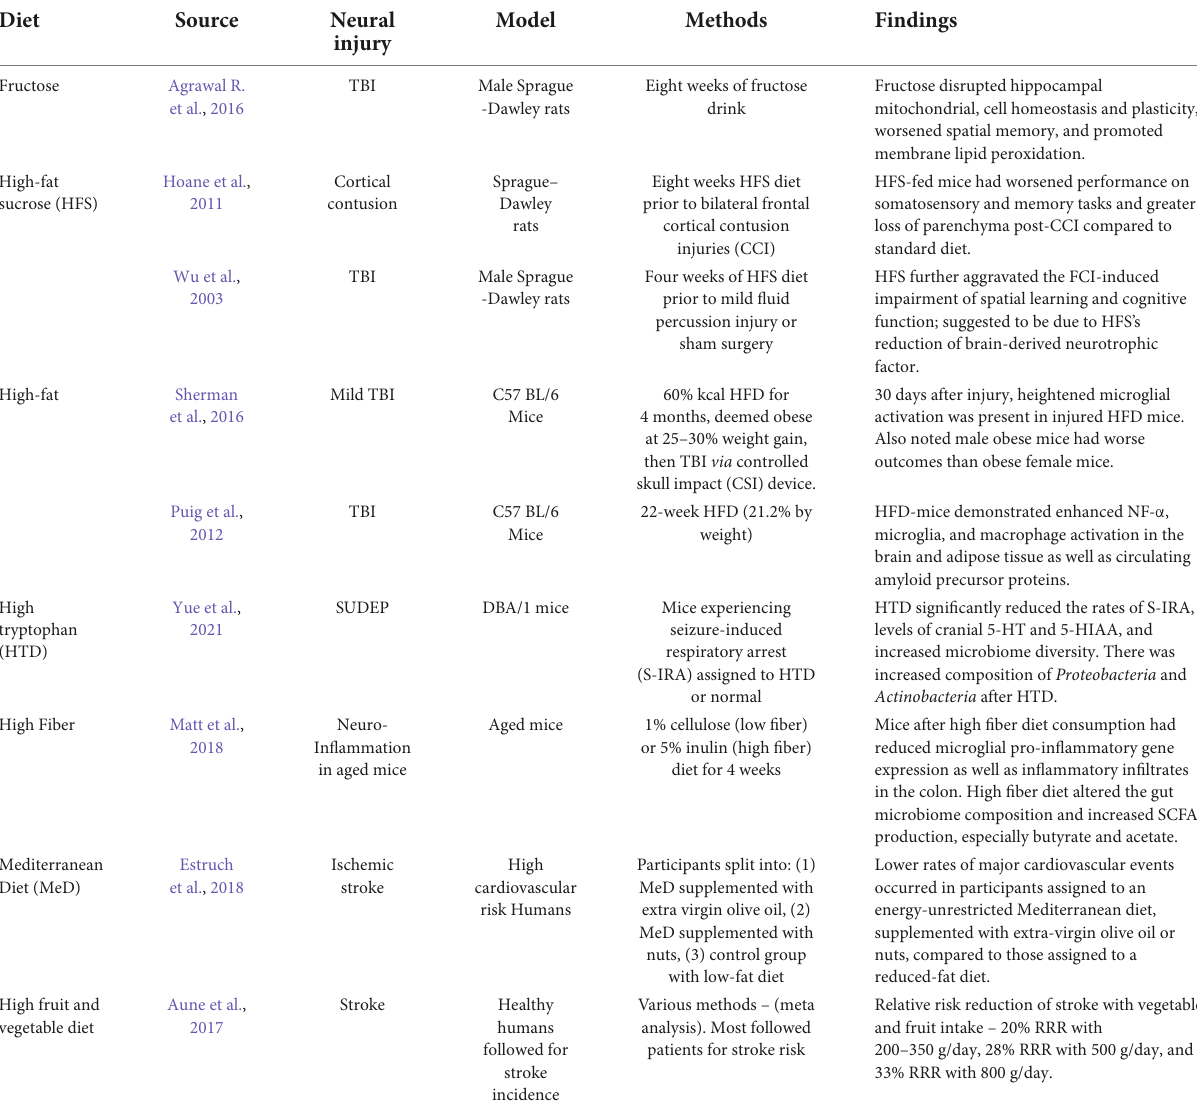
TABLE 1 Summarized findings of diet on brain injury and